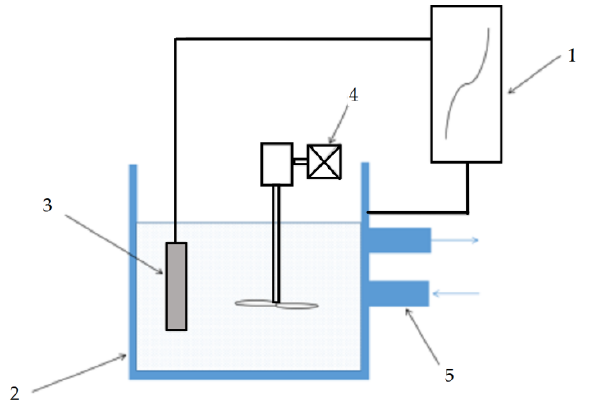
Figure 1. Schematic illustration of the micro-arc oxidation (MAO) device: 1: special power supply; 2: electrolyzer; 3: workpiece to be processed; 4: agitator; and 5: cooling system.